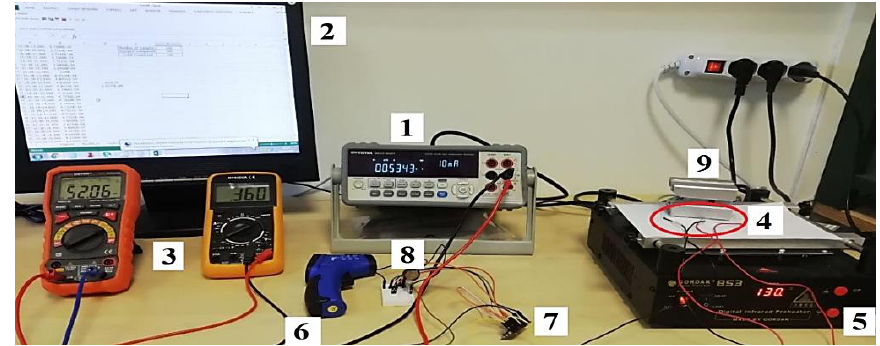
Figure 14. Experimental setup employed for characterization of TEGs.